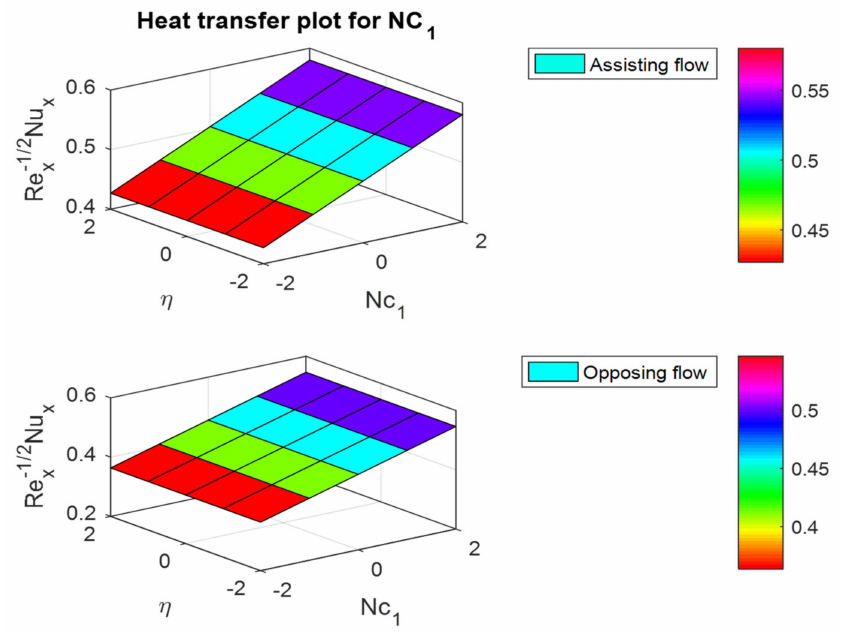
Figure 32. Surface plots for the θ (cid:48) ( 0 ) for dissimilar values of Nc 1 .